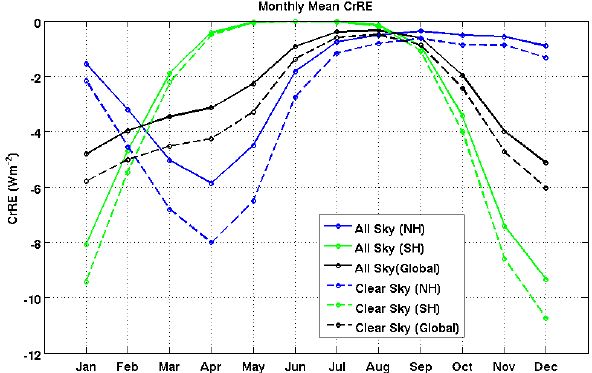
Figure 3. Annual cycle of hemispheric and global LCrRE for both all-sky and clear-sky conditions, derived from the CAM4 radiative